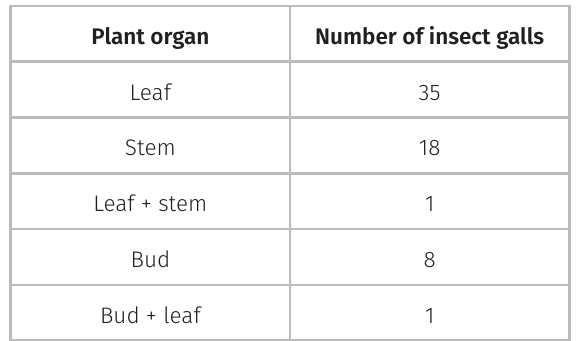
Table II. Richness of insect galls per host plant organ in the Natural Heritage Private Reserve of Serra Negra do Funil (Minas Gerais, Brazil).